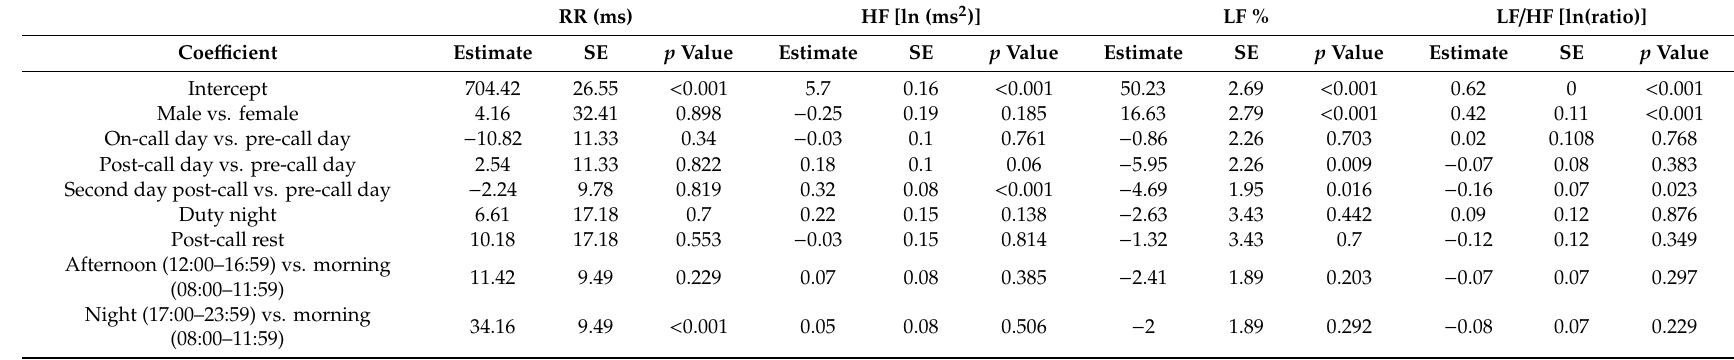
Table 2. Regression coe ffi cients resulting from the construction of a linear mixed-e ff ect model 2 of the HRV among all participants. In this model, we additionally examined the e ff ects of duty night and post-call